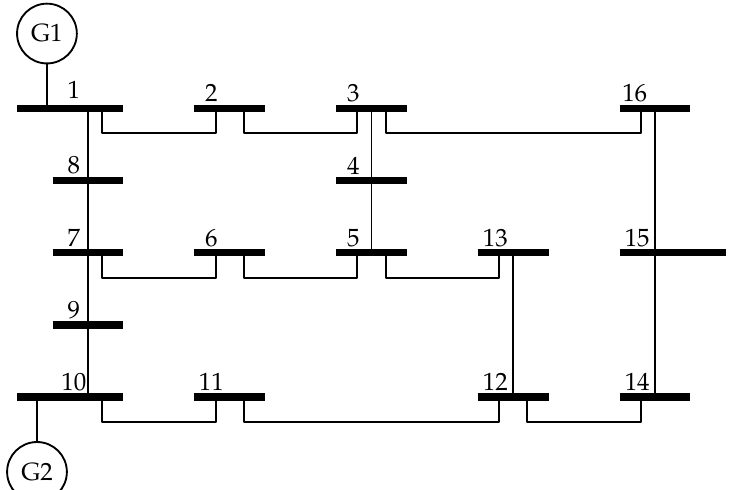
Figure 7. Diagram of the 16-bus system used in tests. Node 1 is a slack bus. Generator G2 represents a PV installation.